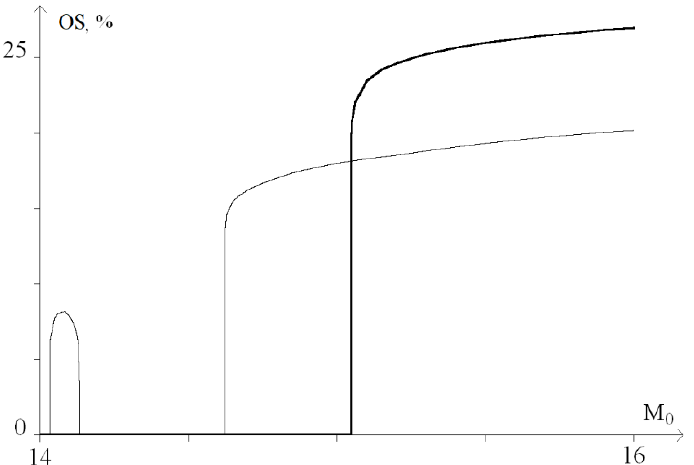
Figure 13. OS regions arising under the localized torque action on the segment [881, 980] for differ- ent M 0 values: a — at M 0 = 14.033, b — at M 0 = 16. Green color indicates OS in A – T pairs, red, in G – C pairs.